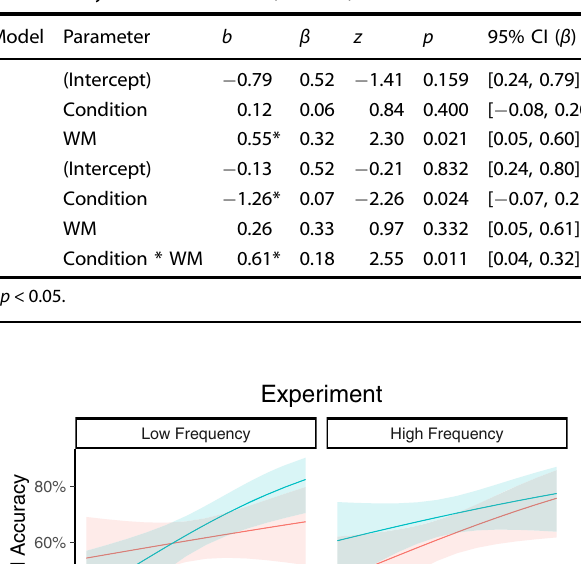
Table 3. Regression coef fi cients of the main effect model (Model 1) and two-way interaction model (Model 2) for LF associations.